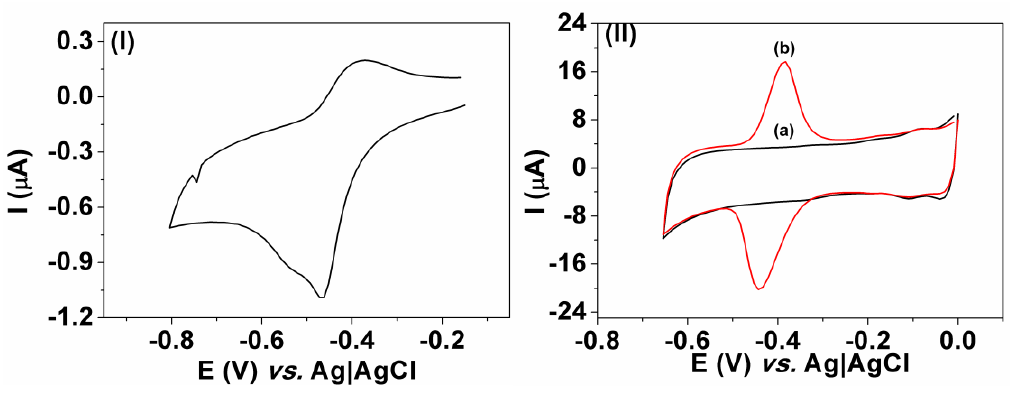
Figure 2. Cyclic voltammograms of the behavior of Acid Green 25 (AG25) upon its reduction on glassy carbon electrode (GCE) ( I ) and on carbon nanotube-modified electrode (CNTME) ( II ) in Britton-Robinson buffer (B-R) solution (a) and in 1 × 10 −5 mol·L −1 of AG25 (b), pH 4.0, B-R buffer (0.04 mol·L −1 ), scan rate of 60 mV·s −1